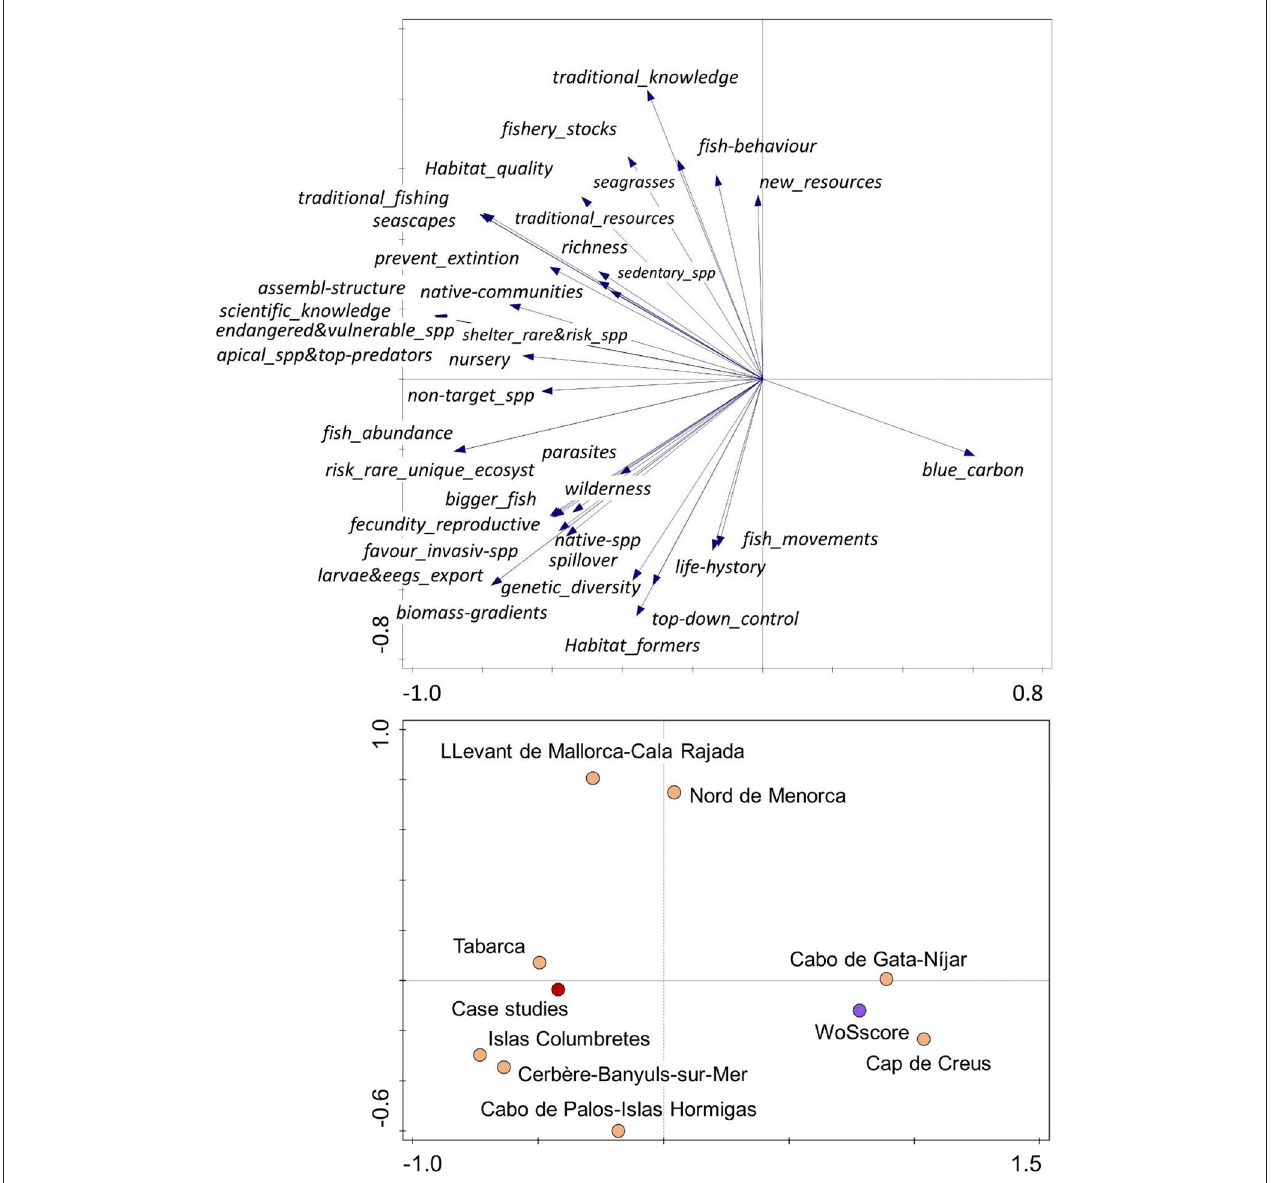
FIGURE 7 | Biplot representations of the first two axes of the PCA performed on the scores matrix of protection effects and ecosystem services observed in RESERVEBENEFIT MPA case studies and according to the percentage of occurrence of the same terms in the articles recorded in the Web of Science (WoS). Above: ordination of the 37 of the 49 terms included in the analyses that passed the rule of having a contribution equal or higher than 10%. Below: ordination of the Western Mediterranean RESERVEBENEFIT MPAs (orange dots) and the WoS scores. Case studies red dot correspond to the average score of all